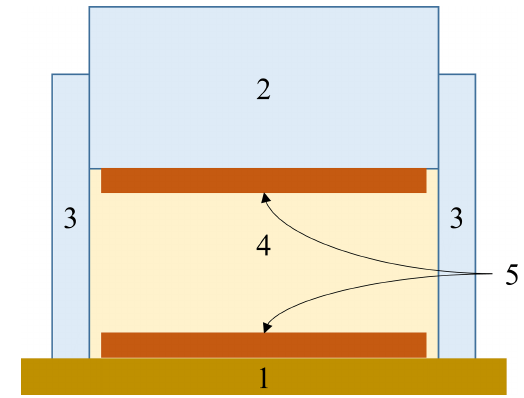
Figure 2. Schematic representation of the measuring cell used. (1) Wooden base plate. (2) Makrolon cylinder. (3) Polymer sur- round. (4) Molding material. (5) Upper and lower copper electrodes (Bifano, 2020).